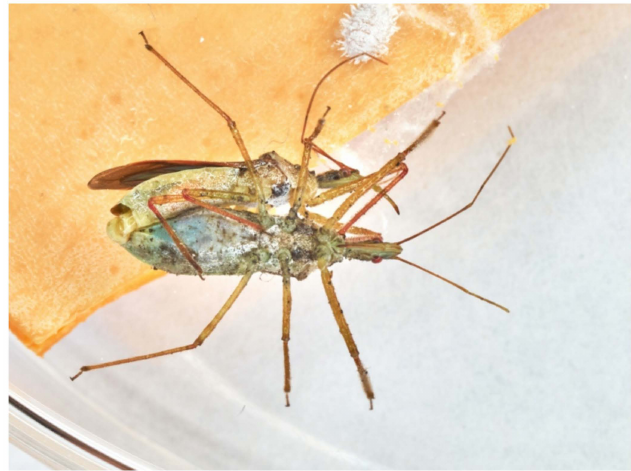
Figure 3. LABs mating in the